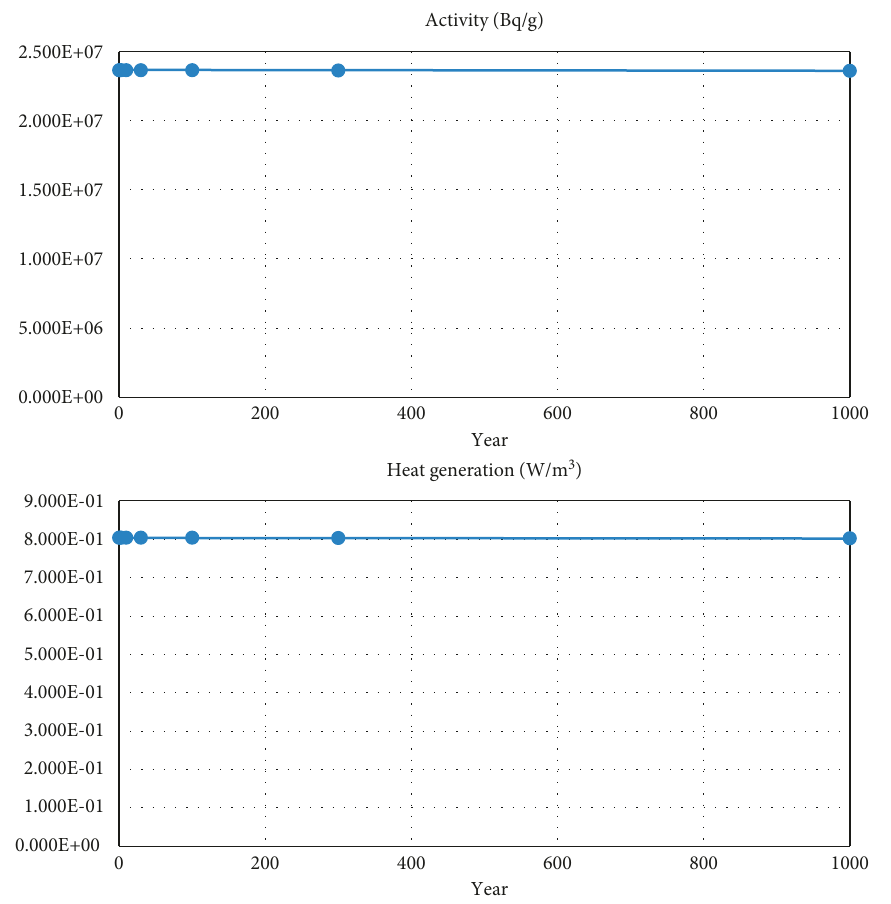
4 ) 2 waste/waste form.